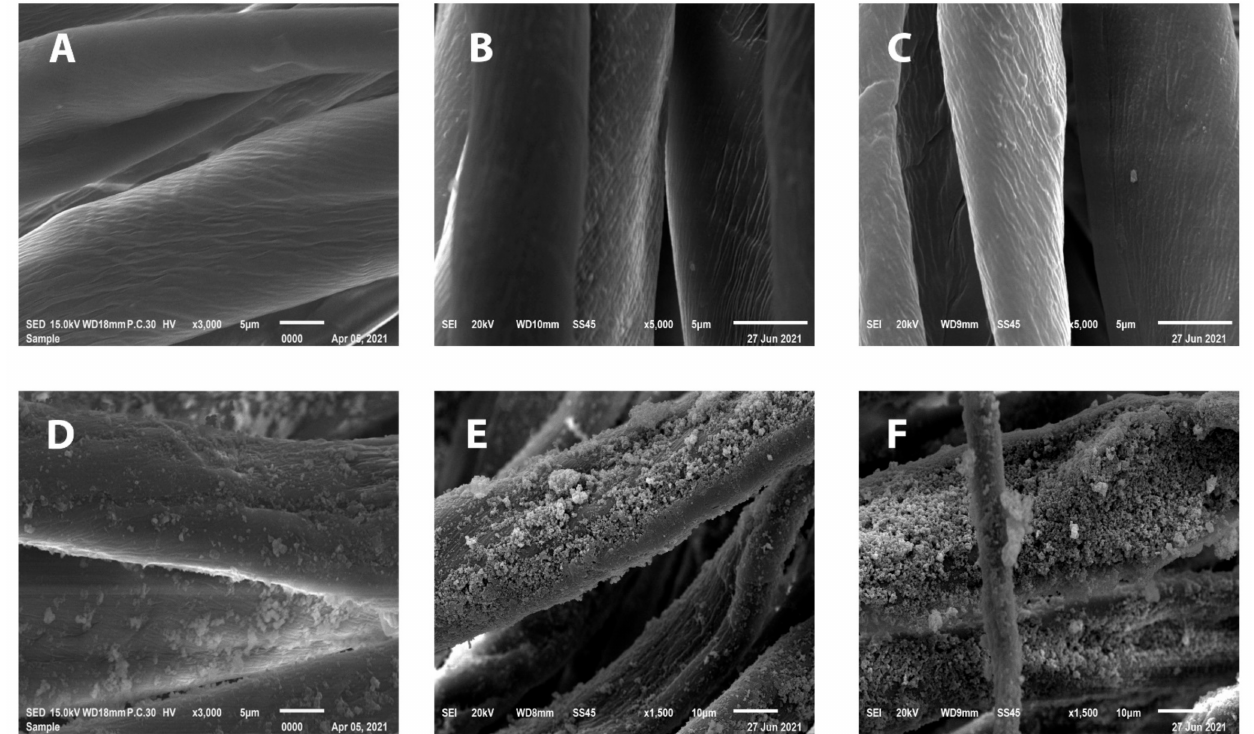
Figure 4. SEM images of ( A – C ) untreated samples. SEM images of cotton/lycra (95.5/5.5%) fabric of 15 pick/cm ( D ), cotton/lycra (90.8/9.2%) fabric of 19 pick/cm ( E ), and cotton (100%) fabric of 22 pick/cm ( F ) treated with SiO 2